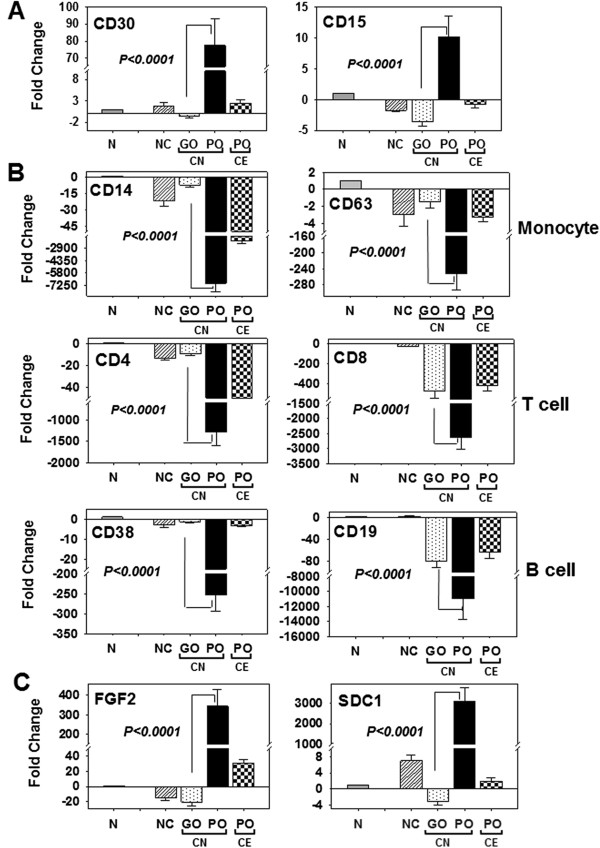
FGF2 and SDC1 are overexpressed in circulating CD15+/CD30+ cells from chemo-naive poor outcome HL patients. qRT-PCR analysis of cells isolated from the buffy-coat of peripheral blood from normal donor controls (NC, striped bar), chemo- naïve (CN) good outcome (GO, dotted) and CN poor outcome (PO, solid black bar) groups, and chemo-exposed PO group (CE, checkered bar). Expression levels are represented as fold-change (y-axis) after normalization with normal control cells (N, solid gray bar: N denotes B cells in A and C; N denotes monocytes, CD4 T cells, CD8 T cells, and CD19 B cells in B). (A) mRNA expression of CD30 and CD15; (B) cell-specific markers for monocytes (CD14, CD63), T-cells (CD4,CD8), and B-cells (CD38, CD19); (C) FGF2 and SDC1. Significance of all qRT-PCR data comparing chemo-naïve GO and chemo-naïve PO is indicated (p < 0.0001; ANOVA and PLSD).